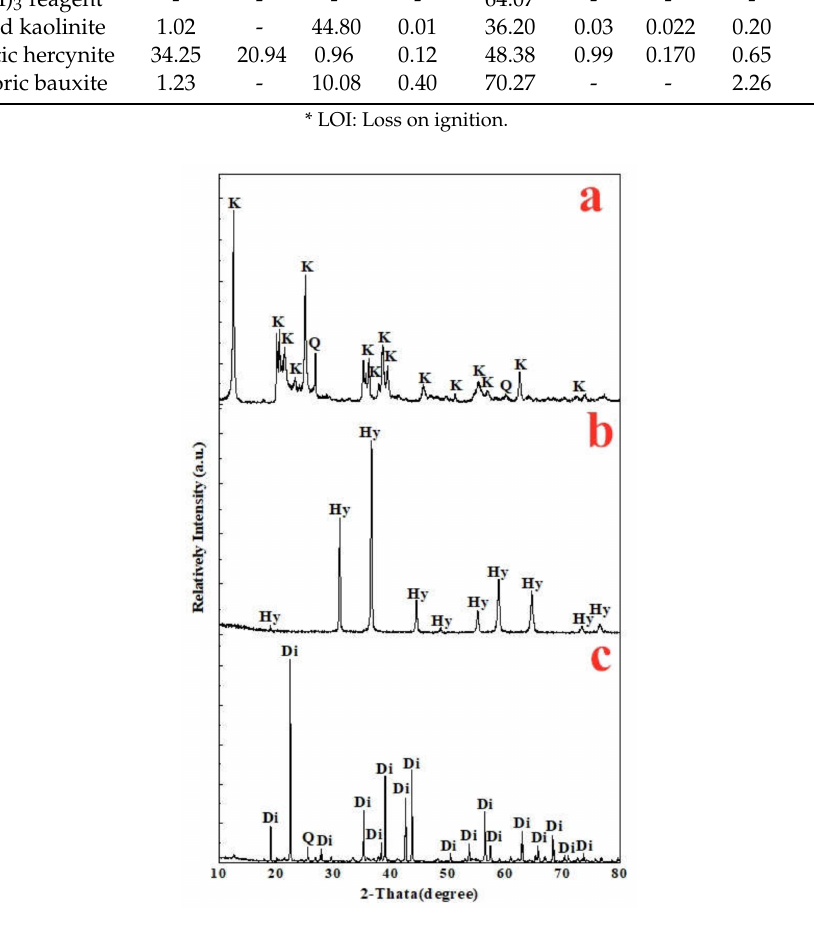
Figure 1. X-ray di ff raction patterns of washed kaolinite ( a ), synthetic hercynite ( b ), and diasporic bauxite ( c ) (K: Kaolinite; Q: Quartz; Hy: Hercynite; Di: